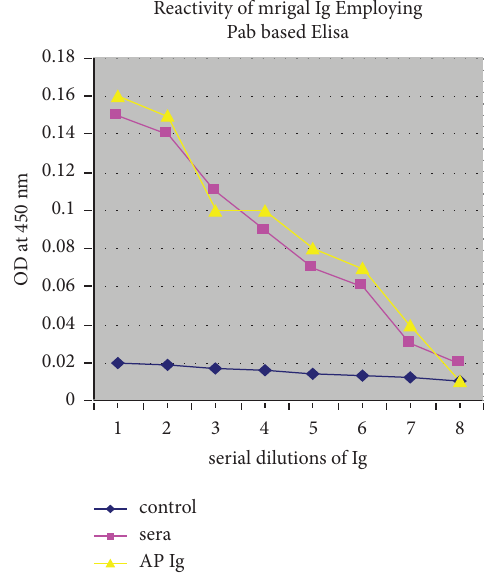
Figure 4: Reactivity study by PAB based